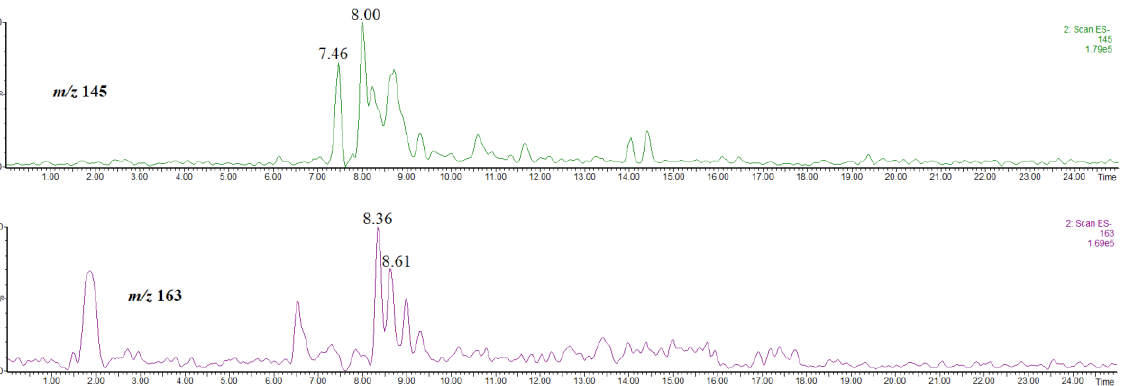
Figure 8. Single ion chromatograms of the ion at m/z 145 and 163, thus the product ions of methyl coumaroylquinates.